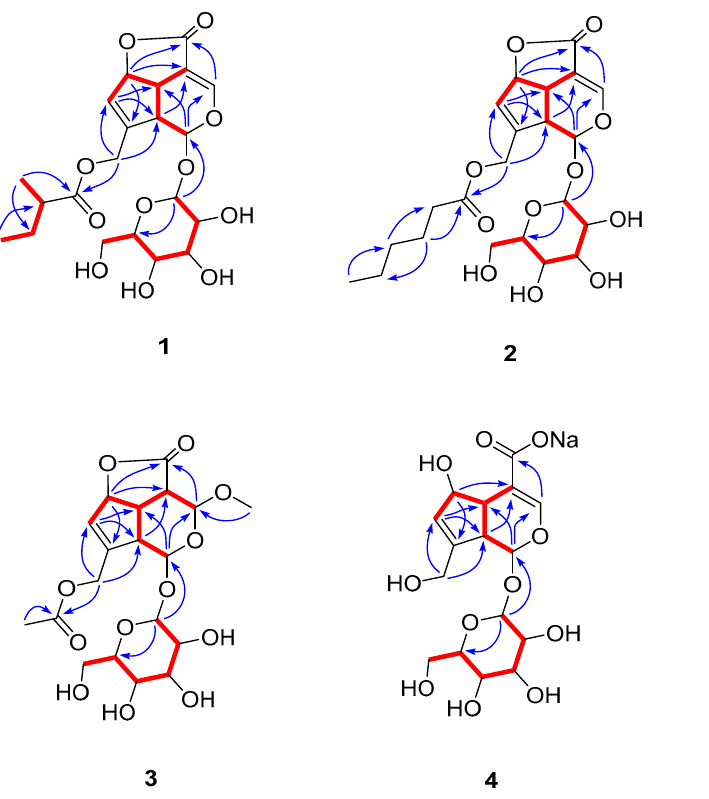
Figure 5. Bold bonds ( ▬ ) represent COSY couplings and curved arrows ( → ) indicate key HMBC correlations of compounds 1 – 4 .